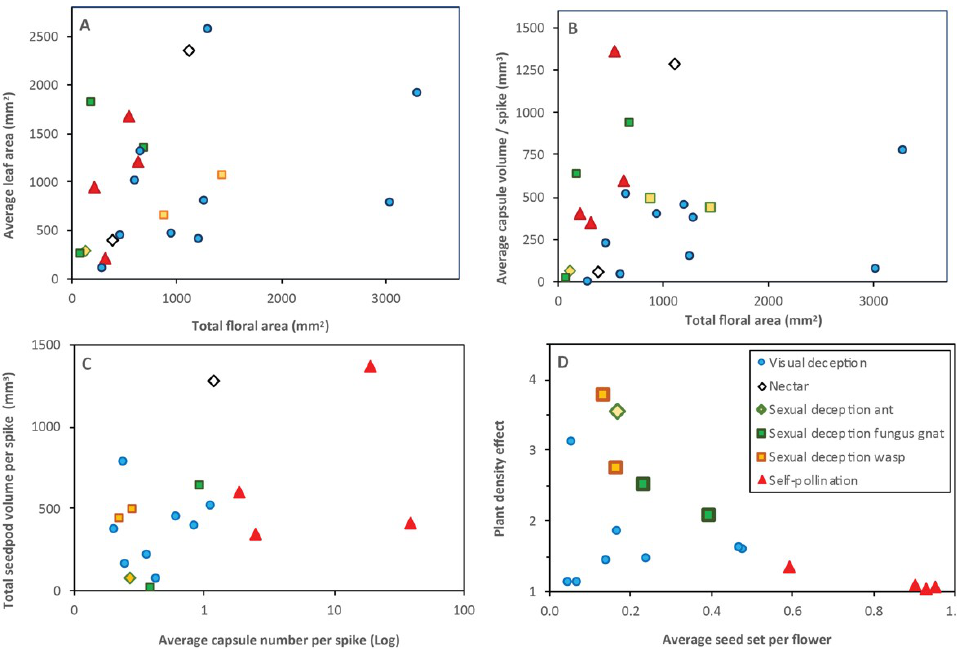
Figure 11. The influence of leaf, flower and capsule sizes or plant density on seed production for orchids with di ff erent pollination traits (one point per species); ( A ) Comparison of leaf and flower area; ( B ) Seed output per spike relative to total flower area per spike; ( C ) Seedpod volume per spike relative to fruit set; ( D ) The impact of plant density on fruit set (small group average / overall mean) relative to average pollination. Orchids with sexually deceptive pollination have larger symbols.